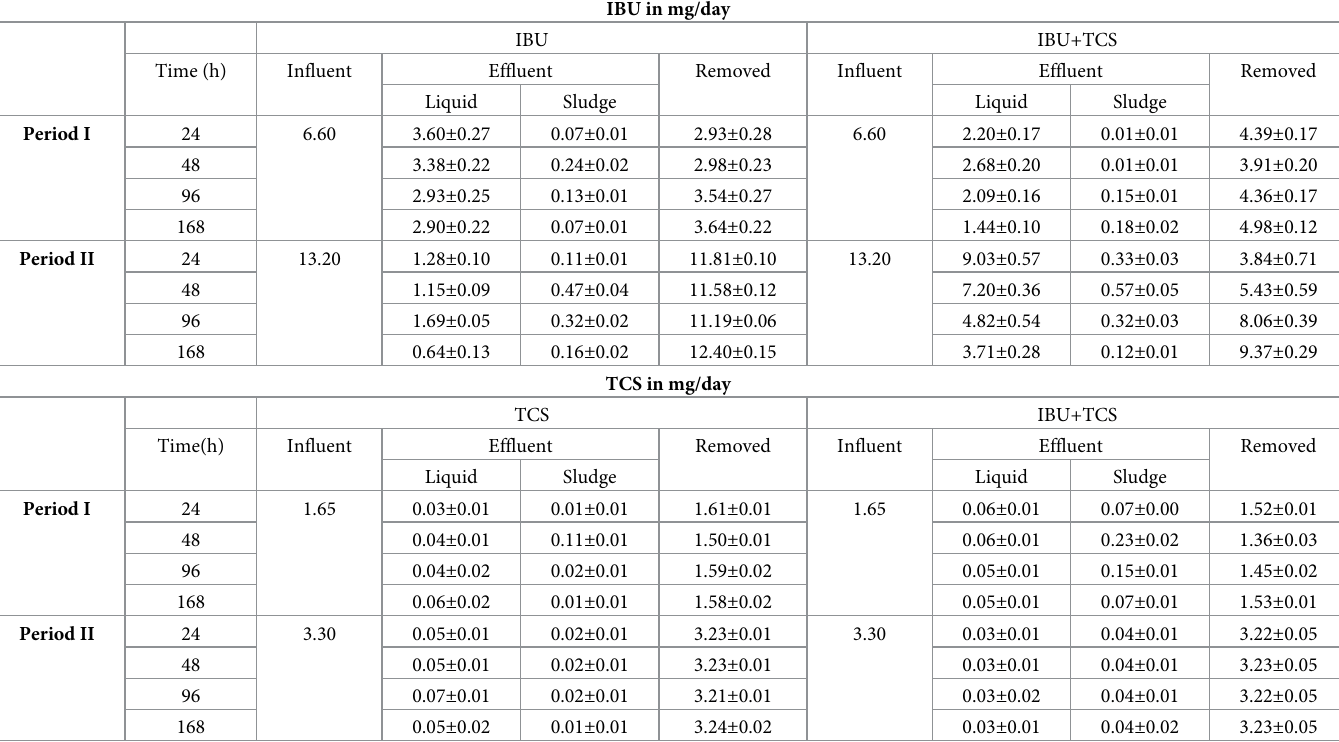
Table 1. Mean amounts of ibuprofen (IBU) and triclosan (TCS) removed and standard deviations (n = 3) in the influent and effluent reactors loaded with pollutants alone or in binary mixture. The amount removed refers to the liquid phase. All amounts are expressed in mg day -1